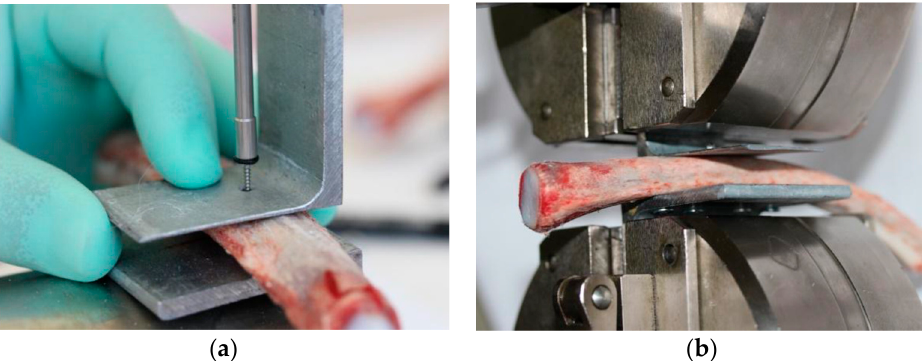
Figure 4. The insertion of the mini-implant into bone, with a 90 ◦ angle, through the hole in the implement ( a ), and the implement attached with fixed and movable parts of the testing machine ( b ).